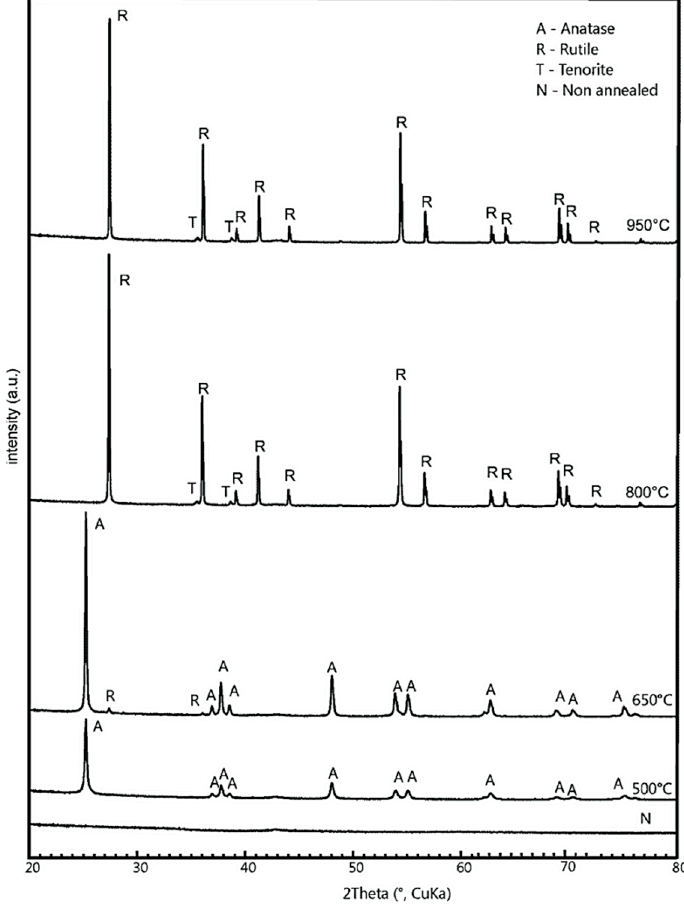
Figure 1. X-ray patterns of Cu/TiO 2 _N, Cu/TiO 2 _500, Cu/TiO 2 _650, Cu/TiO 2 _800 and Cu/TiO 2 _950 MRs.